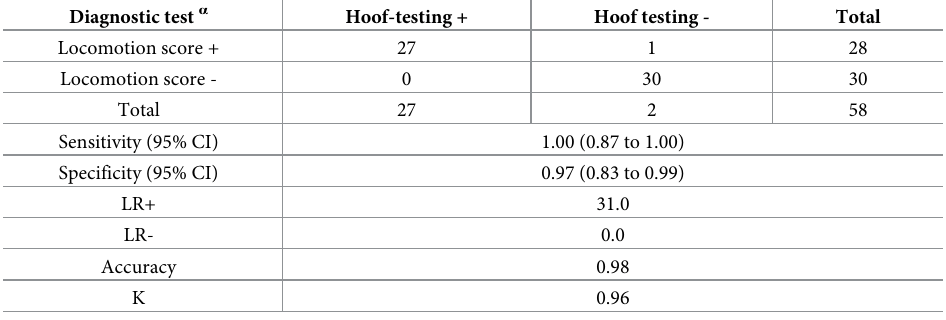
Table 3. Comparison of the locomotion score test with the gold standard hoof testing for the diagnosis of oligo- fructose-induced laminitis in cattle.